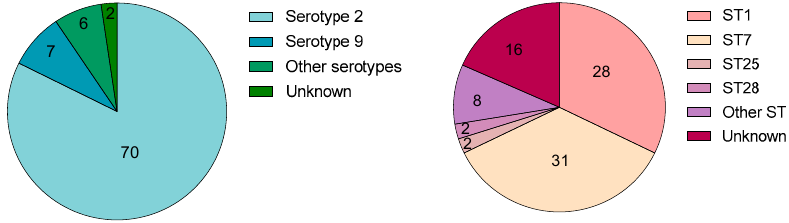
Figure 2. Distribution per S. suis serotypes and/or multilocus sequence typing-based sequence types (ST) of strains used to address S. suis interactions with neutrophils or their role during S. suis infections. If more than one serotype or ST was described in the same study, it appears separately in the graphics. Source: PubMed® (from October 1987 to August 2021).